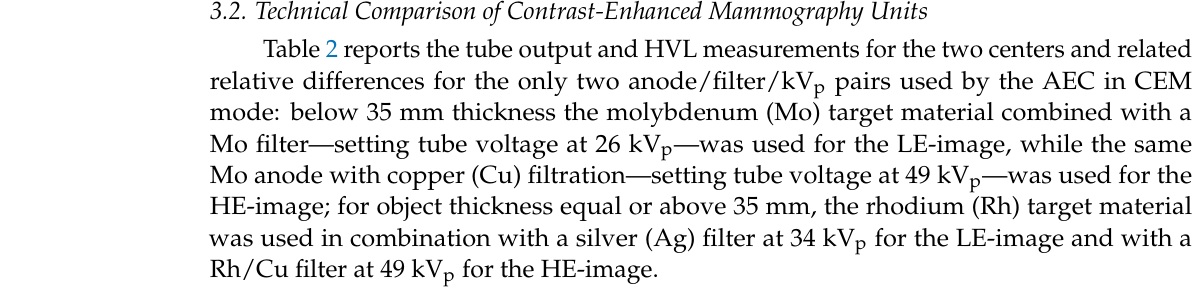
Table 2. Tube output and HVL measurement for the two CEM units installed at Center 1 and Center